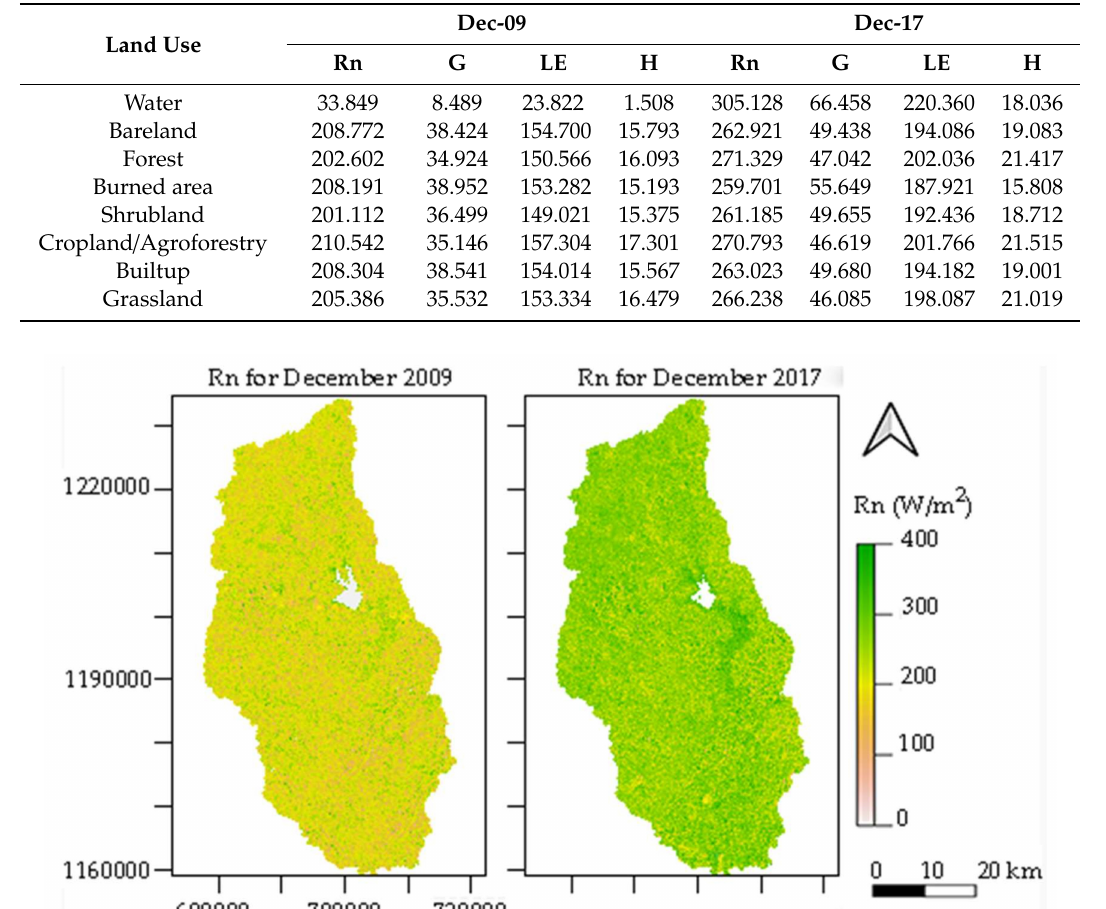
Table 3. Mean flux (W / m 2 ) distribution across the land use types.